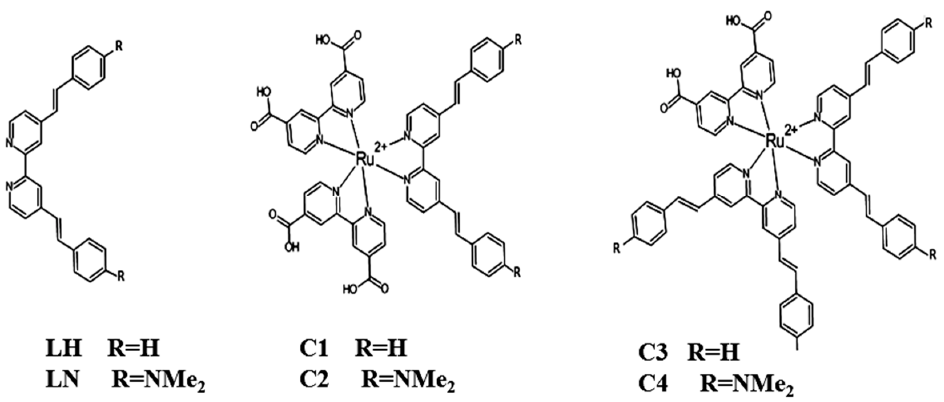
Figure 5. General Structure for unsubstitued (R = H) and substituted (R = NMe 2 ) Chromophoric Ligand (LH, LN) and Ruthenium Complexes. C1: [Ru(bpy(COOH) 2 LH] 2+ ; C2: [Ru(bpy(COOH) 2 (LNMe 2 )] 2+ ; C3: [Ru(bpy(COOH)(LH) 22+ ; C4: [Ru(bpy(COOH)(LNMe 2 ) 2 ] 2+.